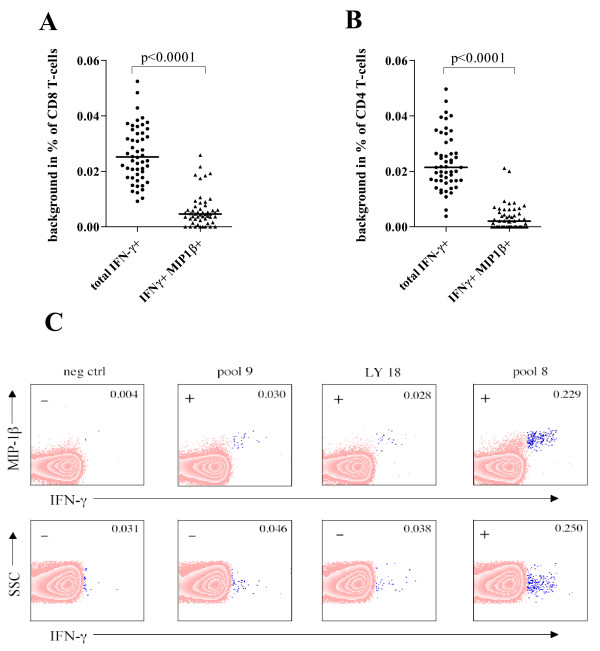
Magnitude of IFN-γ+ MIP-1β+ T-cells and IFN-γ+ T-cells in mock stimulated samples. Percentages of total IFN-γ+ and IFN-γ+ MIP-1β+ CD8 (A) or CD4 (B) T-cells are shown. The lines indicate the median percentage of the observed background. P values were determined by Wilcoxon matched pairs test. In (C) representative data from one study subject are shown. PBMC are gated on CD8+ CD3+ lymphocytes and were stimulated as indicated at the top of the figure. The peptide LDLWIYHTQGYFPDWQNY (LY18), included in pool 8, was here used alone. Data were analyzed with the IFN-γ+ MIP-1β+ (upper row) or the total IFN-γ+ (bottom row) data analysis system. The percentage of IFN-γ+ MIP-1β+ and total IFN-γ+ CD8 T-cells is indicated in the upper-right corner of each plot. Samples were scored as positive or negative (upper-left corner) according to the following procedure. After background subtraction, the 90 percentile of the negative values was calculated and this value was considered as a threshold. Samples were considered positive when higher than the threshold and at least 2 times higher than their respective mock stimulated control.